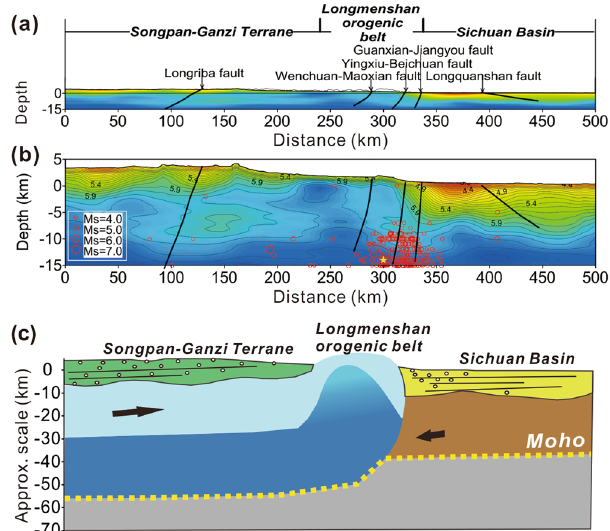
Figure 5. Velocity structure and tectonic model. ( a ) A series of steeply dipping faults with relatively true dips deduced from the fold structure near the surface. ( b ) The high-resolution velocity structure model, overlaid by deduced faults at depth and earthquakes. Red circles denote epicentres of the earthquakes that occurred along the profile since 1978, and the size of circles represents the magnitude. Yellow star is the epicentre of Wenchuan earthquake. ( c ) An interpretive tectonic model of Eastern Tibetan Plateau inferred from the upper crustal model. The arrows indicate the relative motion of the tectonic units. The high-velocity column beneath the LMS fault zone indicates the lower crustal expulsion which contributes to the LMS